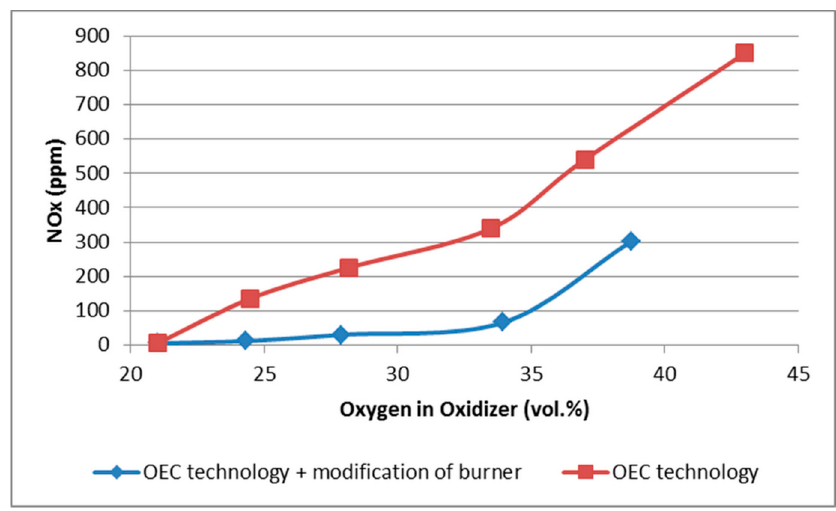
Figure 9. Dependence of NO x concentration in flue gas on concentration of oxygen in oxidizer (experimental measurements).